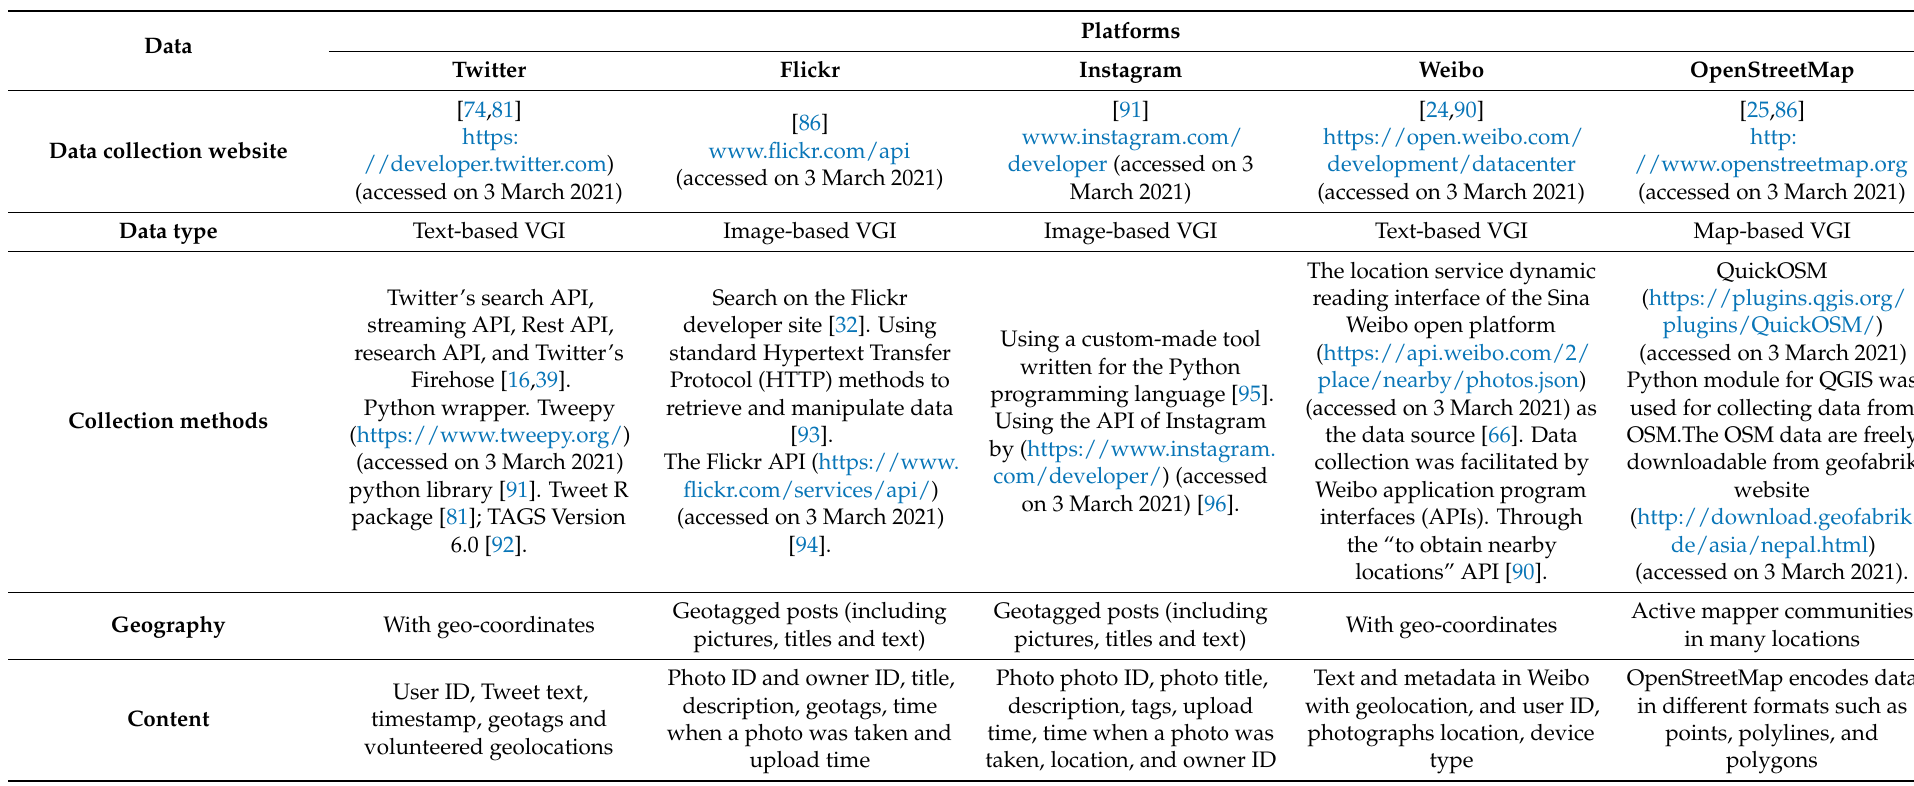
Table 3. The social media platforms used in UGS